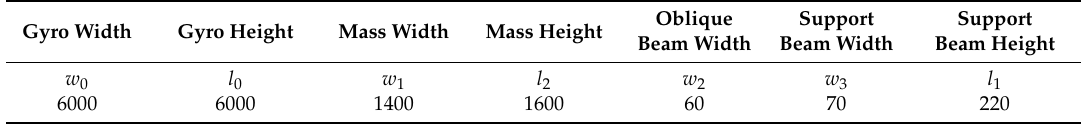
Table 1. Structural parameters of a typical system (unit: µ